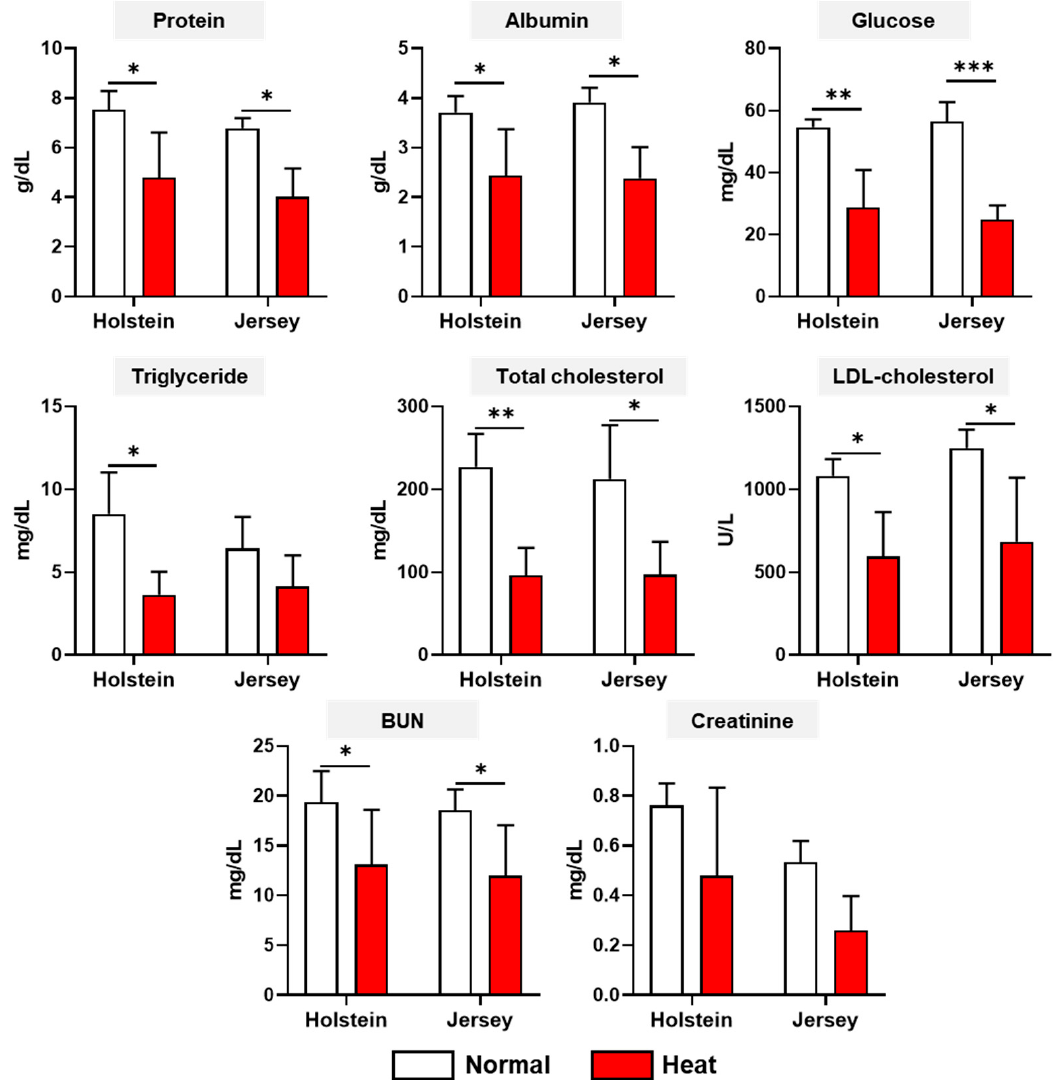
Figure 3. Changes in biochemical metabolites in two breeds of dairy cow under heat stress. Biochemistry analysis of Holstein and Jersey cows was conducted for blood biochemical metabolites under normal and high-heat conditions. Data are represented as means ± standard deviation (SD); n = 7–8 animals/group. Values were statistically analyzed by a mixed-effects model with Tukey’s multiple comparison test. * p < 0.05, ** p < 0.01, and *** p <